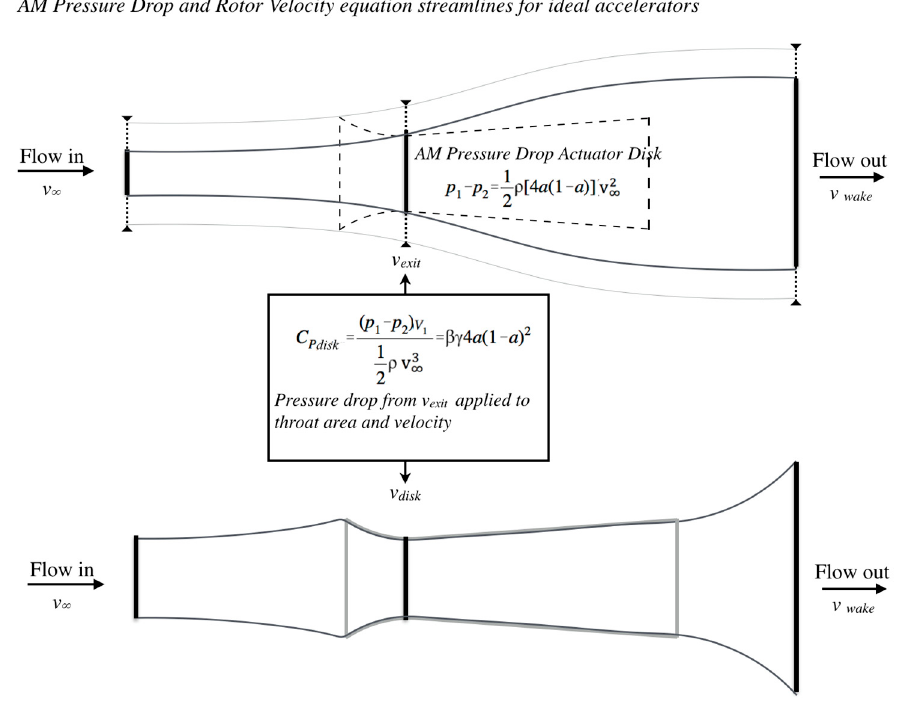
Figure 7. AM Pressure Drop and Rotor Velocity Equation streamlines for ideal accelerators.